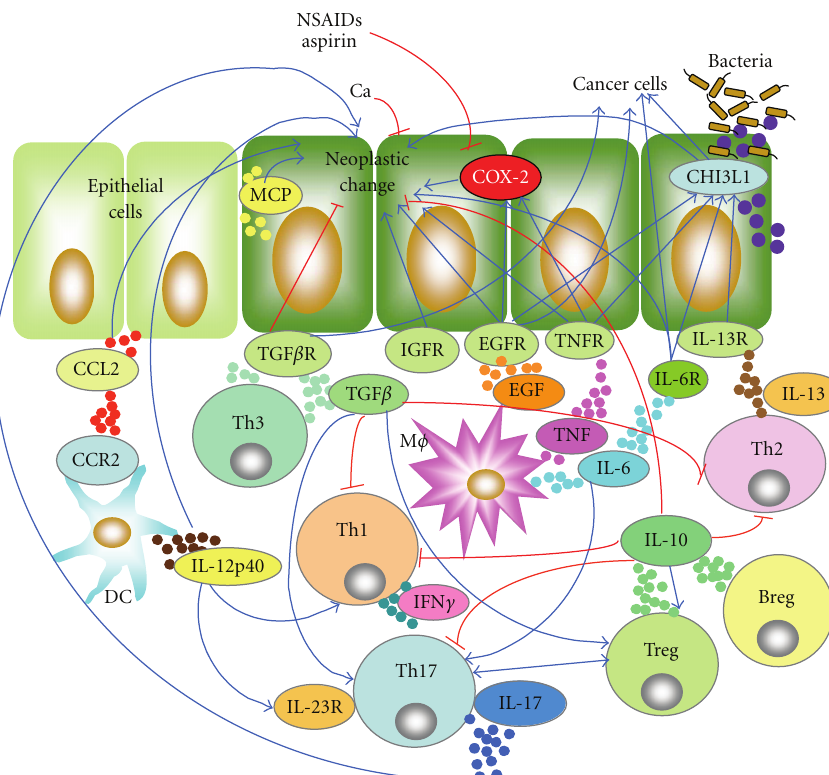
Figure 1: A complicated immune network in colitis-associated cancer (CAC). Previous and current data of CAC in animal models and in man suggest that many cell types as well as soluble factors are involved in the pathogenesis. High levels and continuous production of inflammatory mediators, including cytokines and chemokines by immune cells in lamina propria, may be strongly associated with the pathogenesis of CAC as shown in this figure. Although colonic epithelial cells (CECs) also produce a wide variety of cytokines and chemokines (e.g., IL-8, IL-23, TNF α , TGF β , KC, MCP-1, and MIP1a) under inflammatory conditions and the following CAC development, these factors in CECs are not indicated here in order to simplify the figure. The abbreviations used in this figure are: Breg, regulatory B cells; Ca, calcium, CCL2, chemokine (C-C motif) ligand 2; CCR2, chemokine (C-C motif) receptor 2; COX-2, cyclooxygenase-2; DC, dendritic cells; EGFR, endothelial growth factor receptor; IGFR, insulin-like growth factor receptor; IL, interleukin; MCP, monocyte-chemoattractant protein; M φ , macrophages; NSAIDs, nonsteroidal anti-inflammatory drugs; TGF, transforming growth factor; Th, T helper; TNFR,